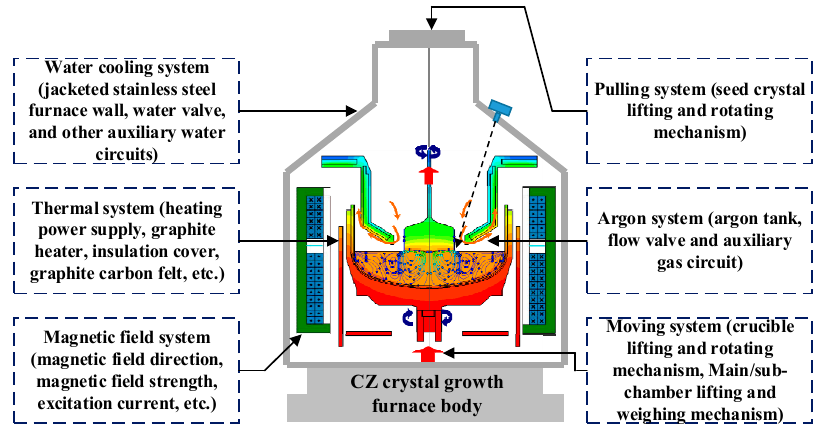
Figure 2. Block diagram of the CZ silicon single crystal growth environment.